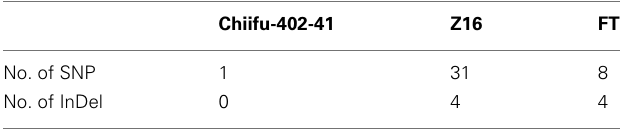
Table 3 | Sequence polymorphisms identified by reference-guided assembly of cp genomes of B. rapa